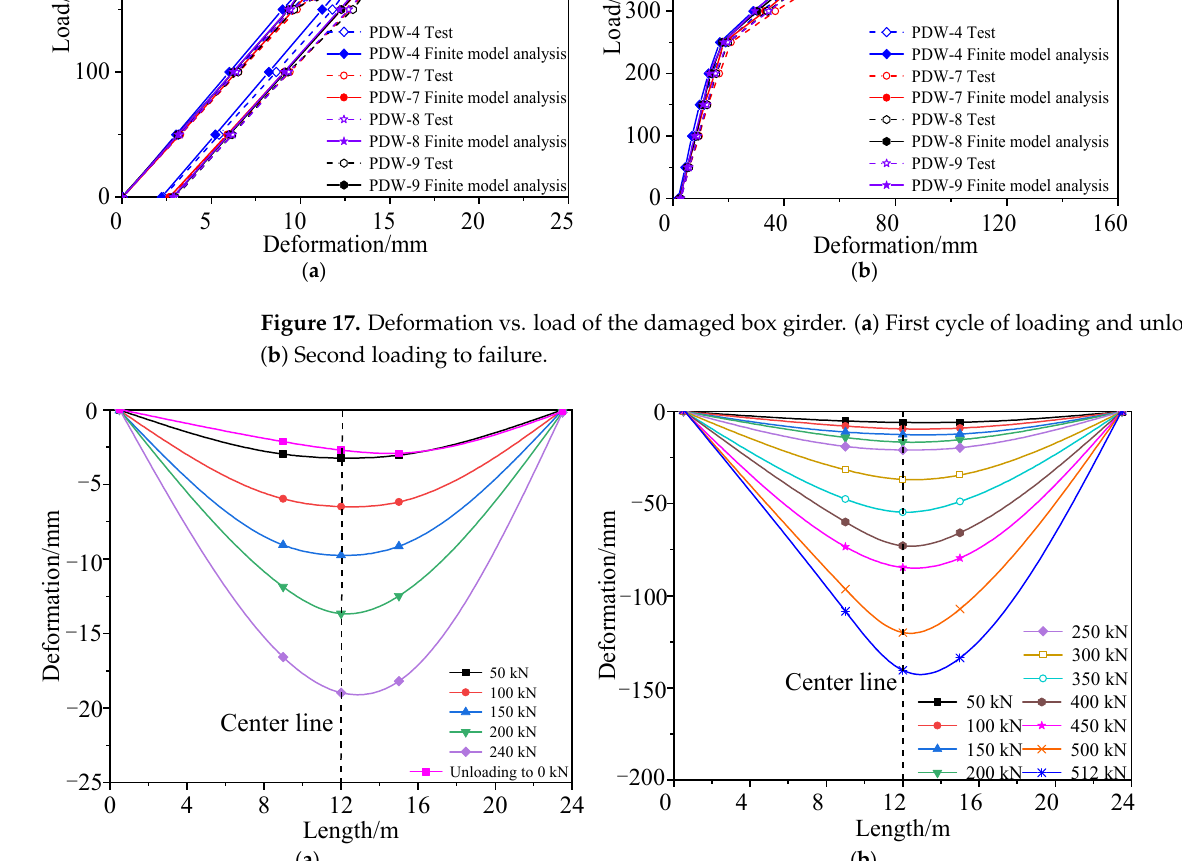
Figure 18. Deformation curve of the damaged test box girder bottom plate. ( a ) First cycle of loading and unloading; ( b ) Second loading to failure. According to the failure test, the strain vs. load data under each load cycle could be obtained, as shown in Figures 19 and 20. Figures 19 and 20 show that the strain of the concrete and steel bars in the damaged area and its vicinity was large, while the strain of other undamaged areas was small. The reason was the lack of concrete in the damaged area and the fracture of steel bars, resulting in local stiffness weakening.